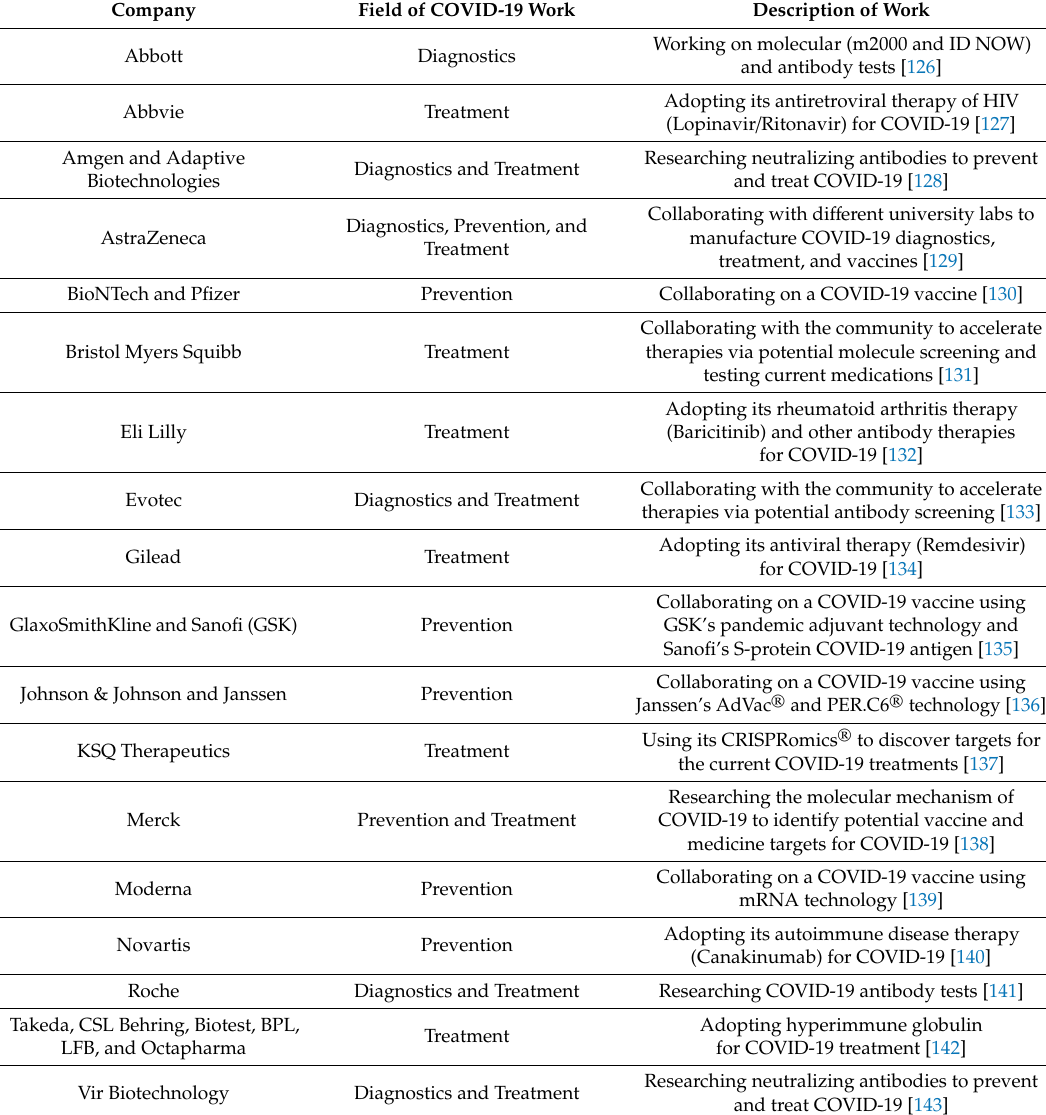
Table 1. This table highlights prominent collaborations of pharmaceutical companies and details on what these companies are working on about COVID-19 diagnostics, prevention, and